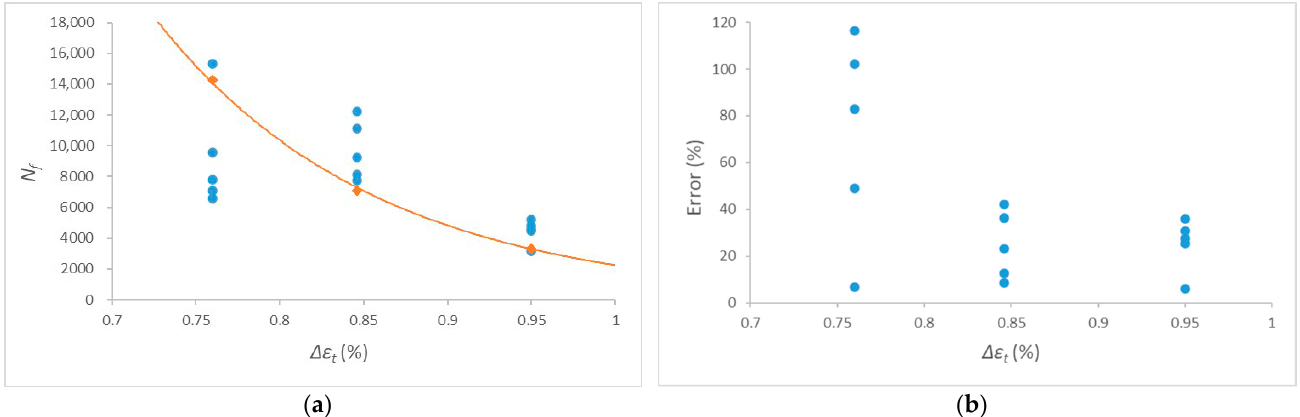
The curve shown in Figure 5a is the fatigue life prediction curve with strain ratio R = 0.05 by Manson-Coffin method, where small triangle marks are those experimental life of the selected specimens. Figure 5b gives the fatigue life errors predicted by the Manson-Coffin model compared with the corresponding experimental life at designed three strain ranges of 0.95, 0.846 and 0.76%.